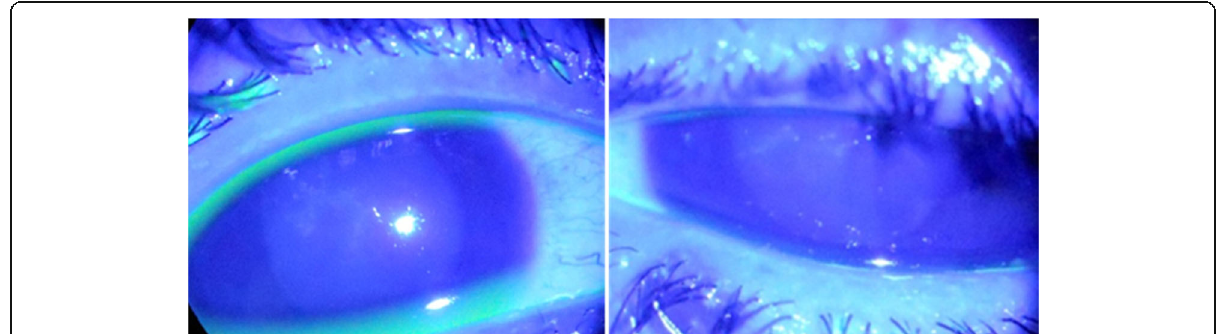
Fig. 2 Right and left eye showing central corneal lesion in a dendritic pattern with minimal fluorescein uptake in cobalt blue